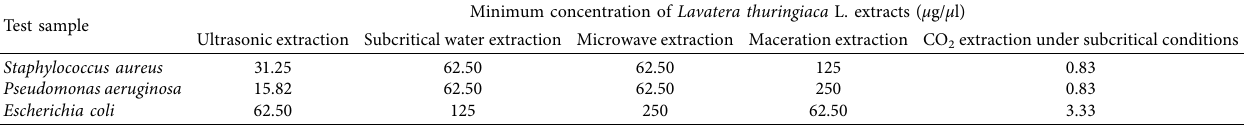
Table 6: Comparative analysis of the results of antimicrobial activity of extracts obtained by extraction methods. Test